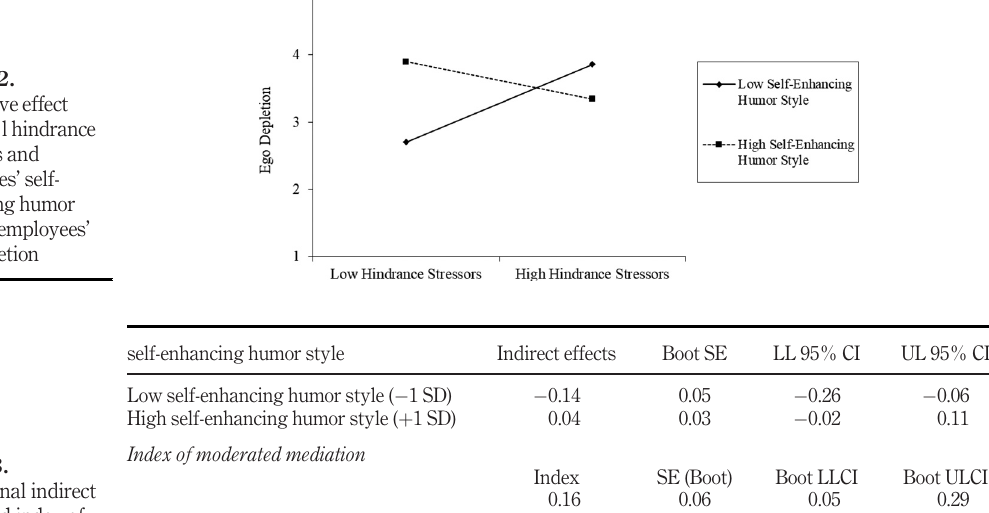
Figure 2. Interactive effect between l hindrance stressors and employees ’ self-